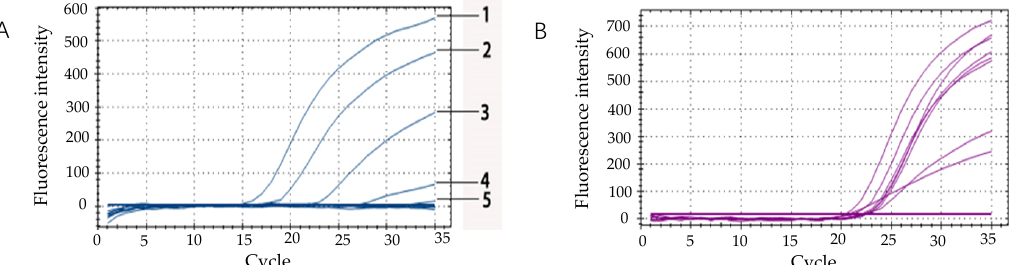
Figure 7. ( A ) Sensitivity test for detection of Escherichia coli O157:H7 in drinking Water by Real-time fluorescent PCR. Line 1: 10 8 CFU / mL; Line 2: 10 7 CFU / mL; Line 3: 10 6 CFU / mL; Line 4: 10 5 CFU / mL; and Line 5: 10 4 CFU / mL. ( B ) Sensitivity test for detection of Escherichia coli O157:H7 in drinking Water when combining IAC with real-time fluorescent